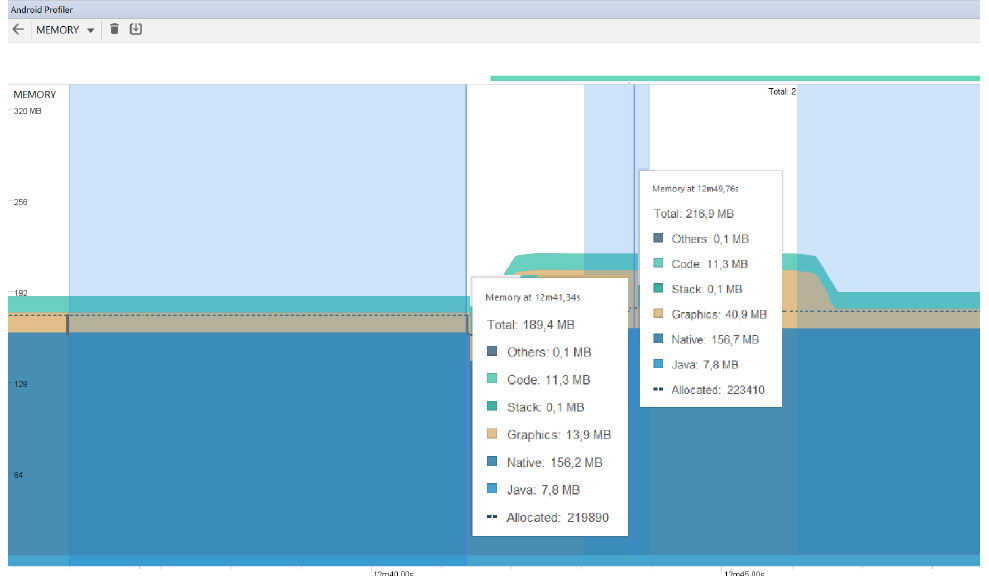
Figure 6. Patient’s device memory